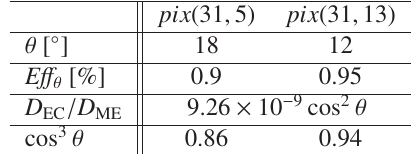
Table 2: Parameters for the arrival photons at ISS window.